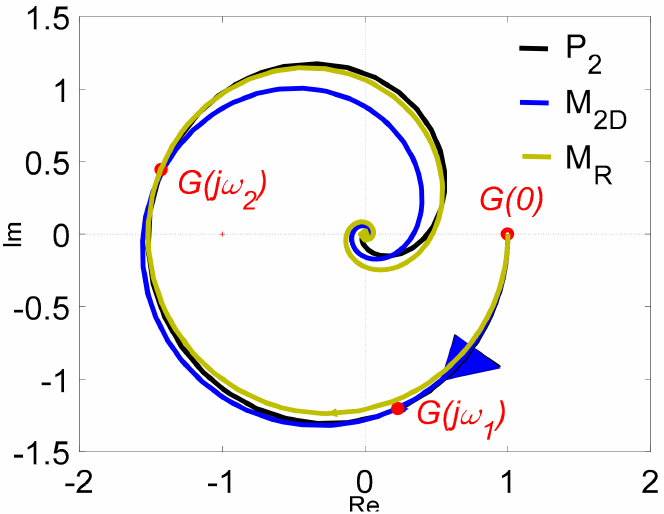
The Nyquist frequency responses of process P 2 ( s ), model M 2D ( s ), model M R ( s ), and points G ( j ω 1 ) and G ( j ω 2 ) are shown in Figure 12.